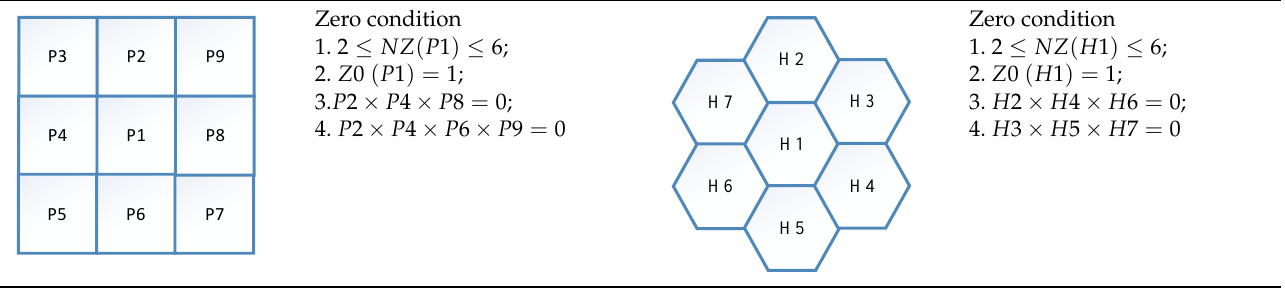
The original data The original data D Error area Error area Hexagonal data Error band Hexagonal